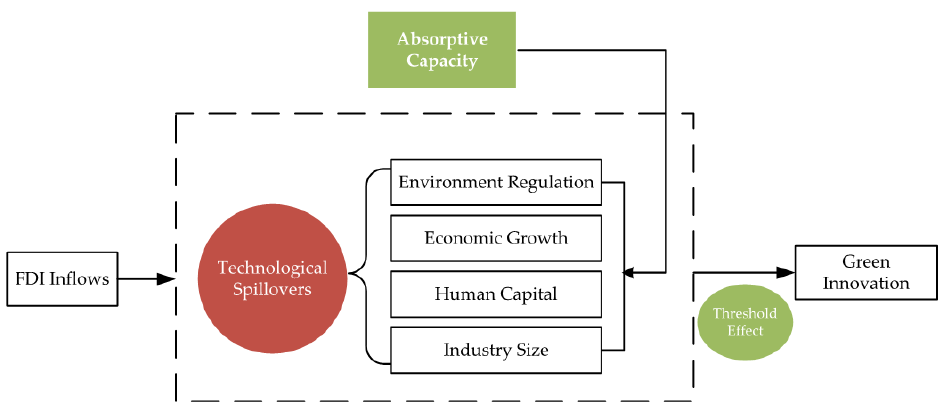
Figure 1. Theoretical framework.